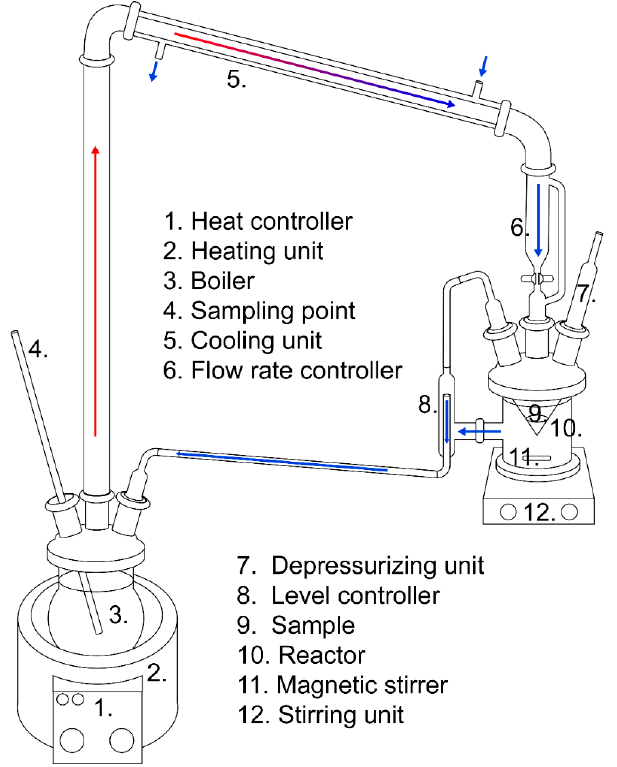
Figure 1. Schematic overview of the dynamic leaching apparatus.